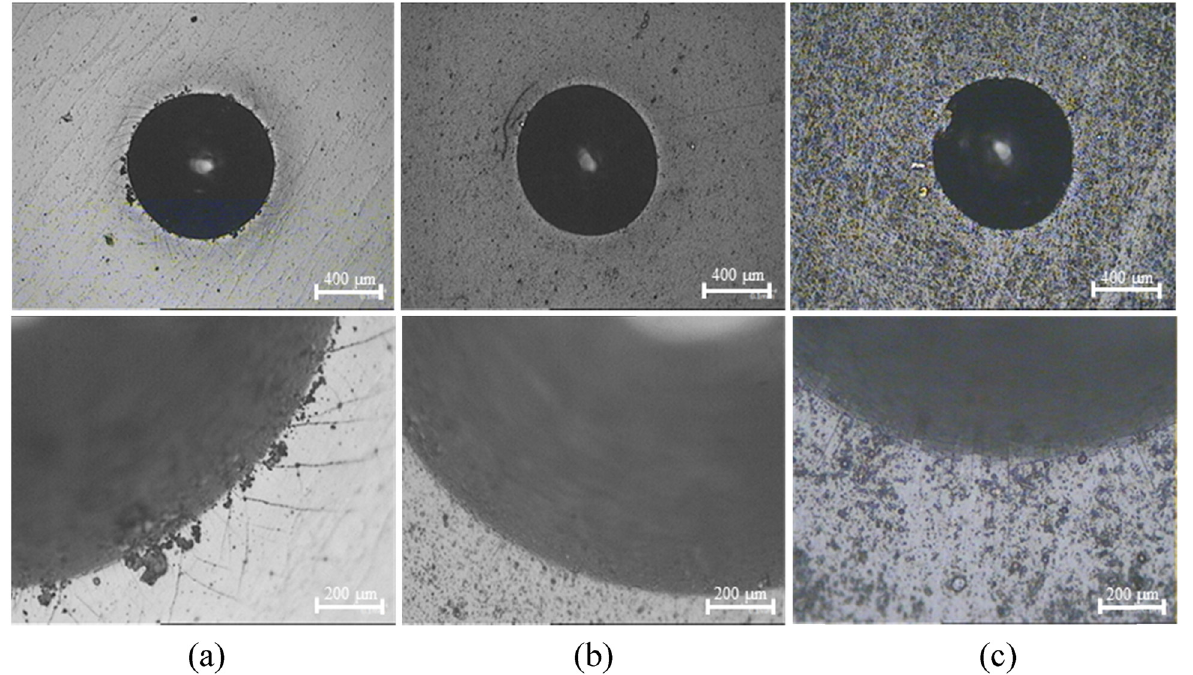
Figure 3: Optical metallography images of indentations for ( a ) TiN coating, ( b ) TiAlN coating, ( c ) TiAlCrN coating. Note: The images in the fi rst line are in 100 × , while the images in the second line are in 500 ×